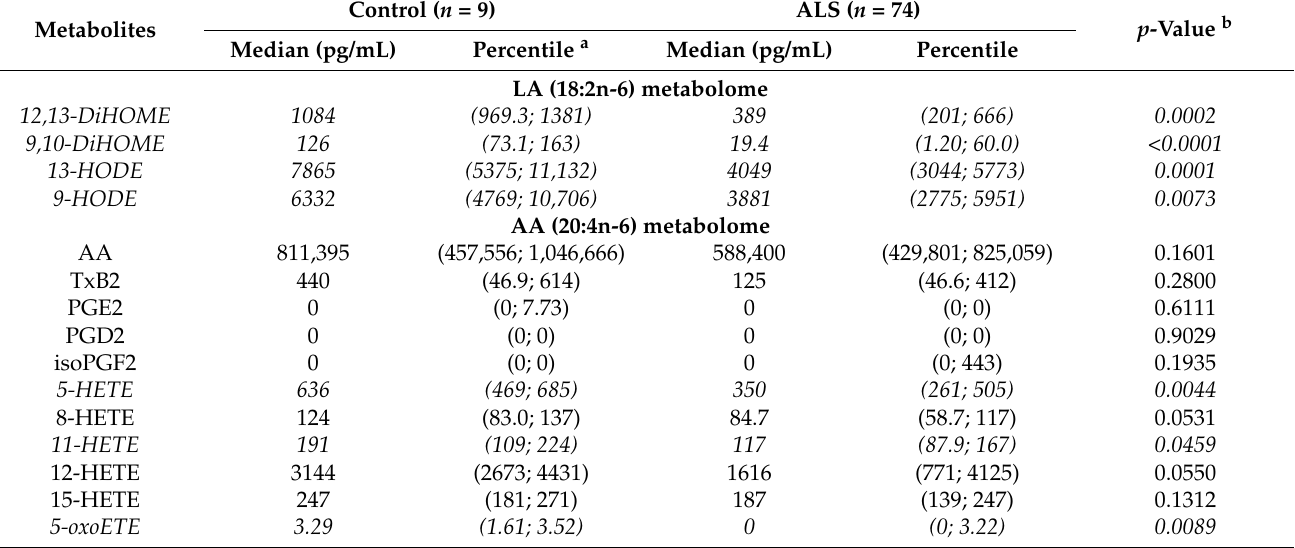
Table 2. Plasma oxylipin concentrations in Control and ALS samples assessed by